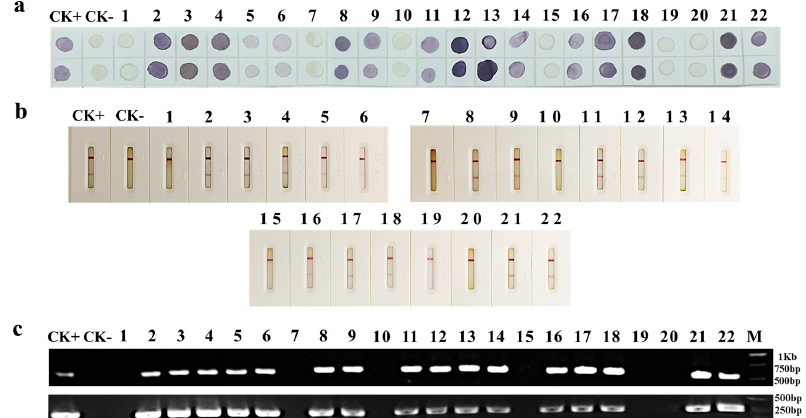
Figure 5. Detection of PPV infection in field-collected tree leaf samples through the newly developed dot-ELISA, CGICS, and RT-PCR, respectively. ( a ) A do-ELISA test using two dots per sample on the same membrane and MAb 13H4 as the detection antibody. Field-collected Japanese apricot tree leaf samples (samples 1 to 19) and common apricot tree leaf samples (samples 20–22) were tested for PPV infection. CK+ and CK- were a known PPV-infected and a known uninfected Japanese apricot leaf sample, respectively. ( b ) The CGICS test of field-collected samples, the same as in Figure 5a. ( c ) RT-PCR analyses using a conserved PPV primer pair PPV-F and PPV-R ( lower panel) or the PPV-D strain specific primer pair PPV-D-F and PPV-D-R ( upper panel). The RT-PCR products were about 250 bp and 600 bp, respectively.